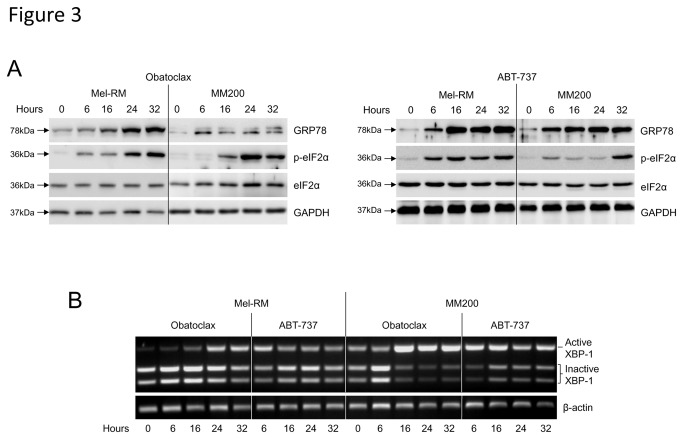
Obatoclax and ABT-737 activate the UPR in melanoma cells.A. Following treatment of melanoma cell lines Mel-RM and MM200 for indicated periods with Obatoclax (1nM) or ABT-737 (10µM), whole cell lysates were subjected to Western blot analysis for the ER stress markers GRP78 and phosphorylated eIF2α. Data are representative of three individual experiments.B. Expression of the active form of XBP-1 was determined by agarose gel electrophoresis following Apa-LI digestion of XBP-1 mRNA. Indicated is the longer (active) fragment and the two shorter (inactive) bands. Data are representative of three individual experiments.